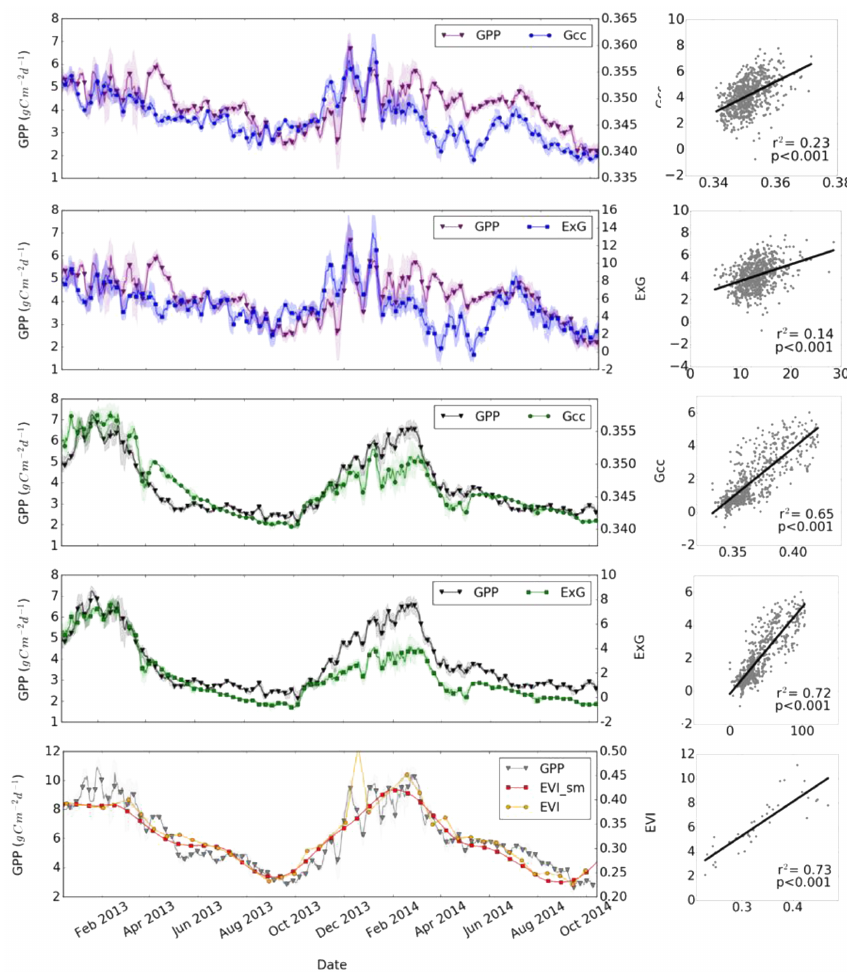
Figure 7. Overstory (a, b) and understory (c, d) flux tower GPP with green chromatic coordinate (GCC) and excess green (ExG) indices, as well as ecosystem flux tower GPP with MODIS enhanced vegetation index (EVI, e ), from December 2012 to October 2014 at the Howard Springs OzFlux site. Daily data are shown with an 8-day running mean (marked every 8 days for visualisation) applied. The standard error of the mean is given by the shading. Included for each time series are the respective regression plots showing r 2 and p values for GCC– ExG–EVI ( x ) against flux tower GPP ( y ). For MODIS EVI (e) the time series plot includes raw 16-day values (EVI) and a Savitzky–Golay smoothed daily EVI product (EVI_sm), with the regression plot showing the raw 16-day EVI and the corresponding GPP for that